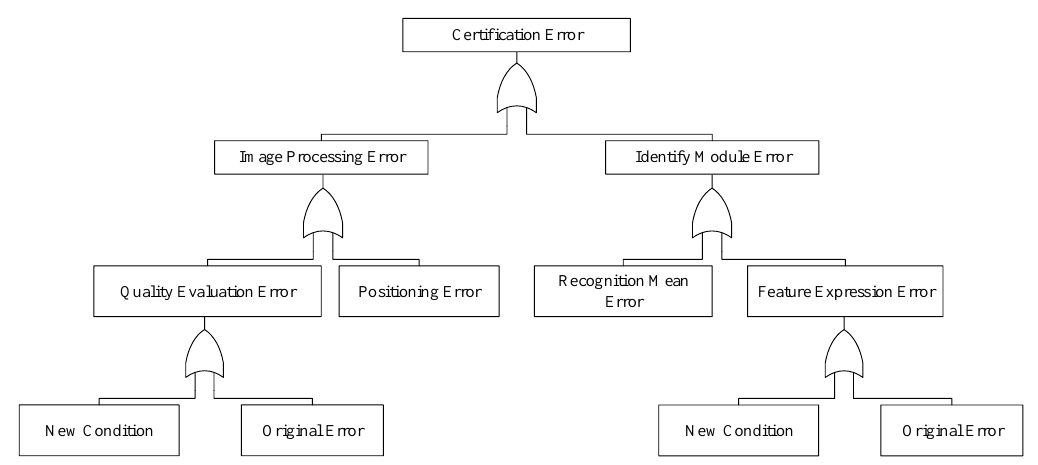
Figure 4. The fault tree of the certification model in the case of certification error.